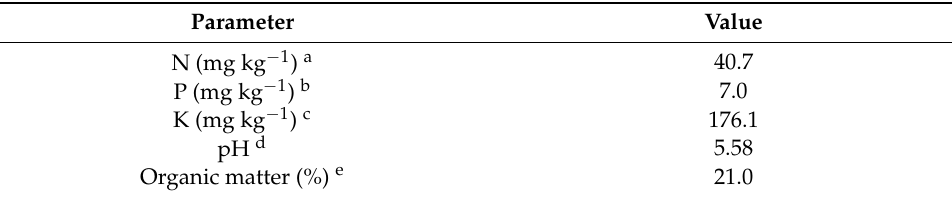
Table 1. Main chemical properties of the soil used in the experiment.